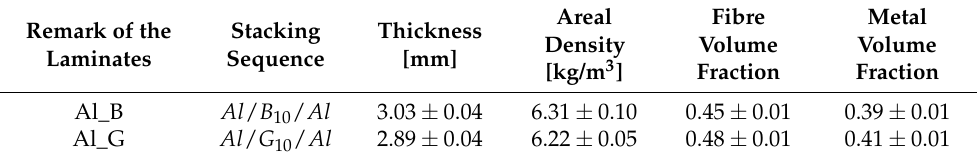
Table 2. FMLs samples manufactured.